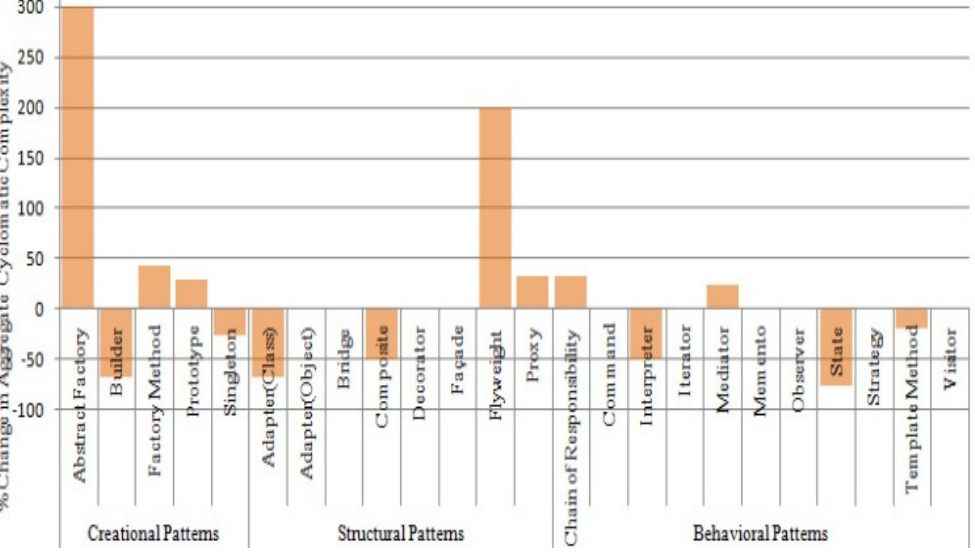
FIG. 4. IMPACT OF DESIGN PATTERNS ON PROGRAM AGGREGATE CYCLOMATIC COMPLEXITY